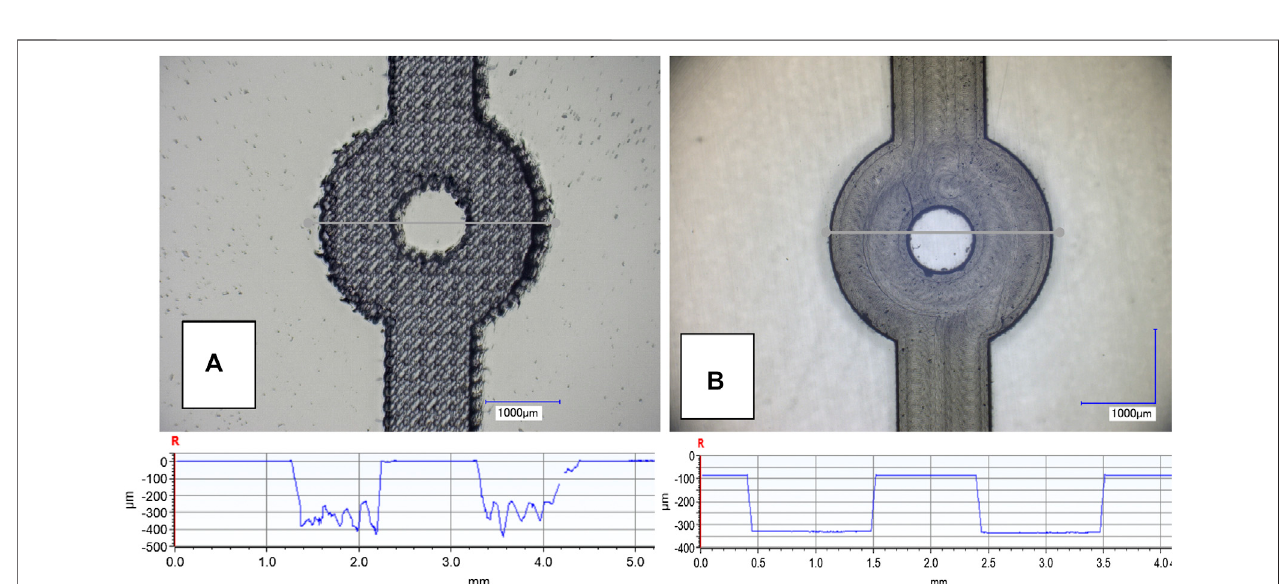
FIGURE 6 | Microscope image of the micro fl uidic channel and valve retention pillar fabricated using laser ablation (A) and micro milling (B) , and associated cross sections obtained using optical pro fi lometry. The micro-milled channels give a much smoother fi nal fi nish with an average surface roughness in the region of 3 – 5 µm compared to 50 – 150 µm obtained with laser